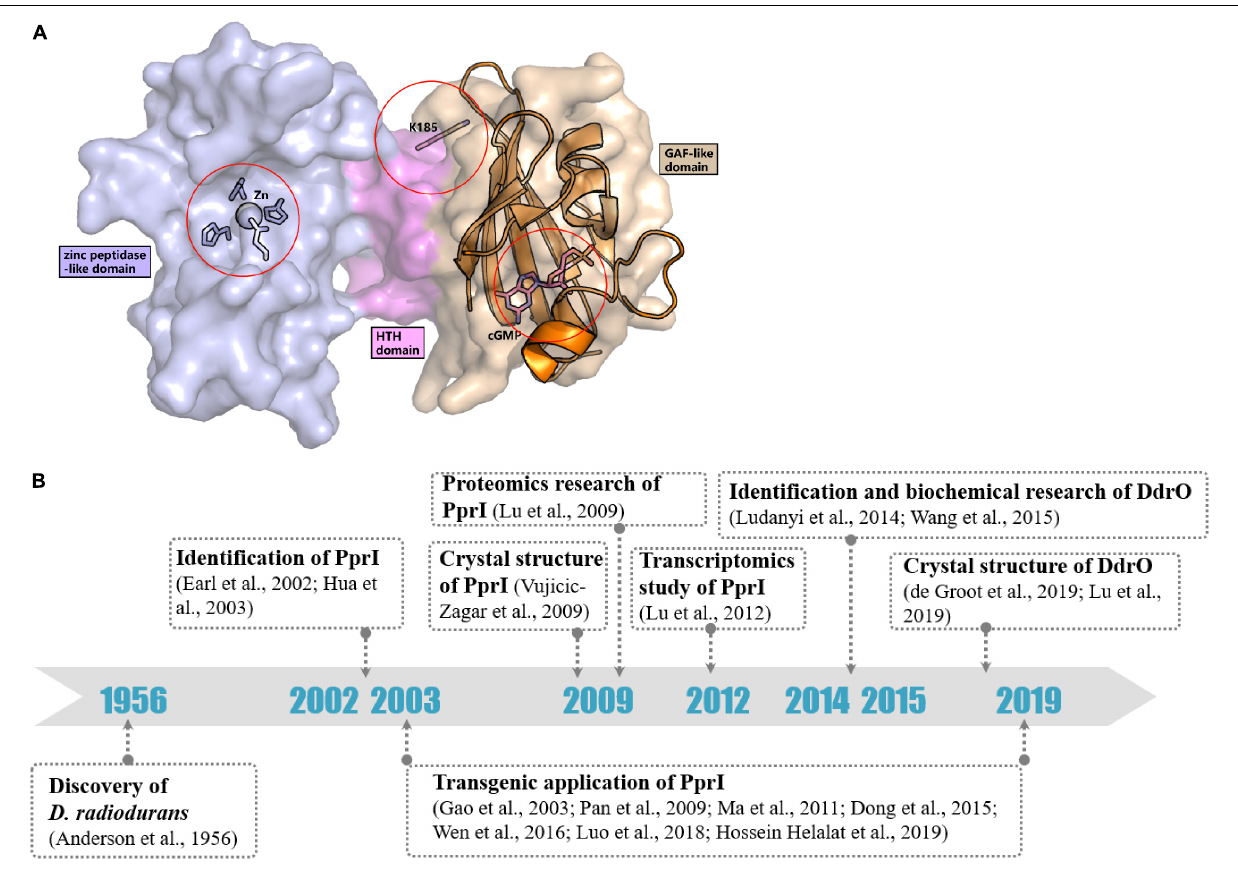
FIGURE 2 | Activation hypotheses and timeline of important discoveries of PprI. (A) Three hypotheses of the PprI activation are present on the structure of DR_PprI, which is from the homolog modeling (Swiss model) using D. deserti protein (PDB: 3DTE) as the starting model. DR_PprI is shown as surface, and the zinc peptidase-like domain, helix-turn-helix motif and GAF-like domain are colored in light blue, magenta, and wheat, respectively. Related residues are shown as sticks. The aligned structure of PDE2A (RCSB PDB code 1MC0) is shown as cartoon. The four residues and metal ion in the NTD zinc peptidase-like domain represent the metal hypothesis. The Lys185 residue represents the posttranscriptional modification hypothesis. The cGMP in the GAF-like pocket by alignment represents the small molecule hypothesis. (B) Timeline of the important discoveries of